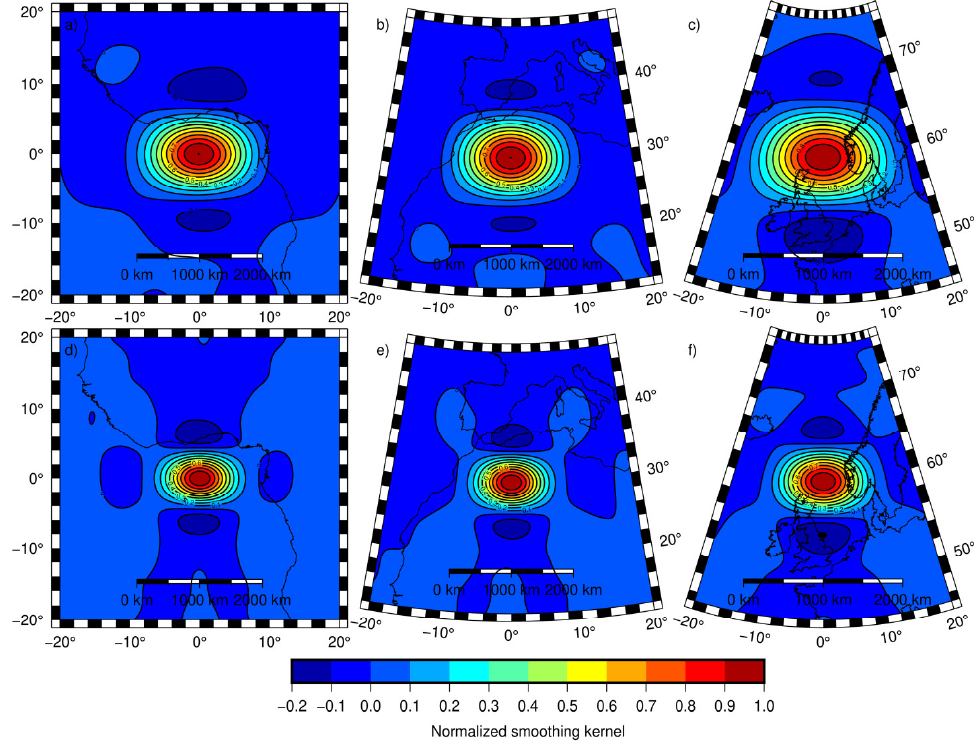
Figure 3. The normalized smoothing kernel weights with kernel center located at different latitudes: 0° ( a , d ), 30° ( b , e ), and 60° ( c , f ) along the 0° meridian. The adaptive DDK filters for September 2006 ( a , b ) and July 2010 ( d – f ) with power indices selected as 6.5 and 3.4, and with regularization coefficients selected as 1 × 10 15 and 5 × 10 18 , respectively.